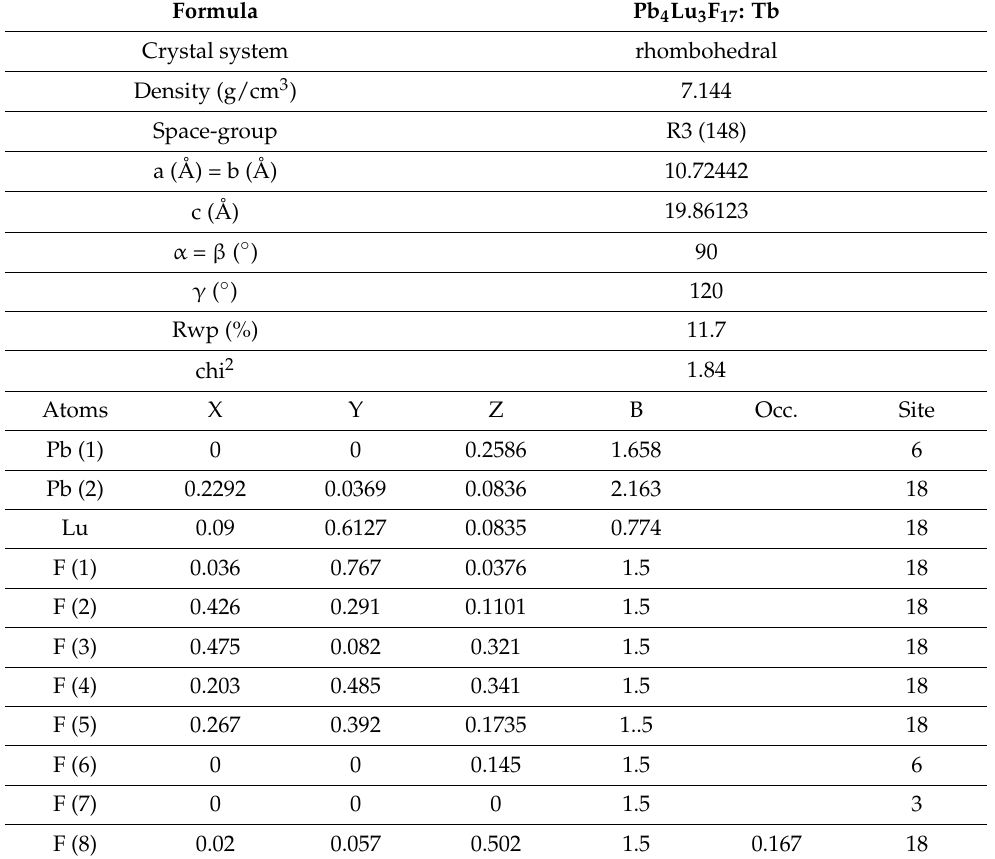
Table 1. The Rietveld refinement results, cell paraments and atomic position coordinates for the Pb 4 Lu 3 F 17 :